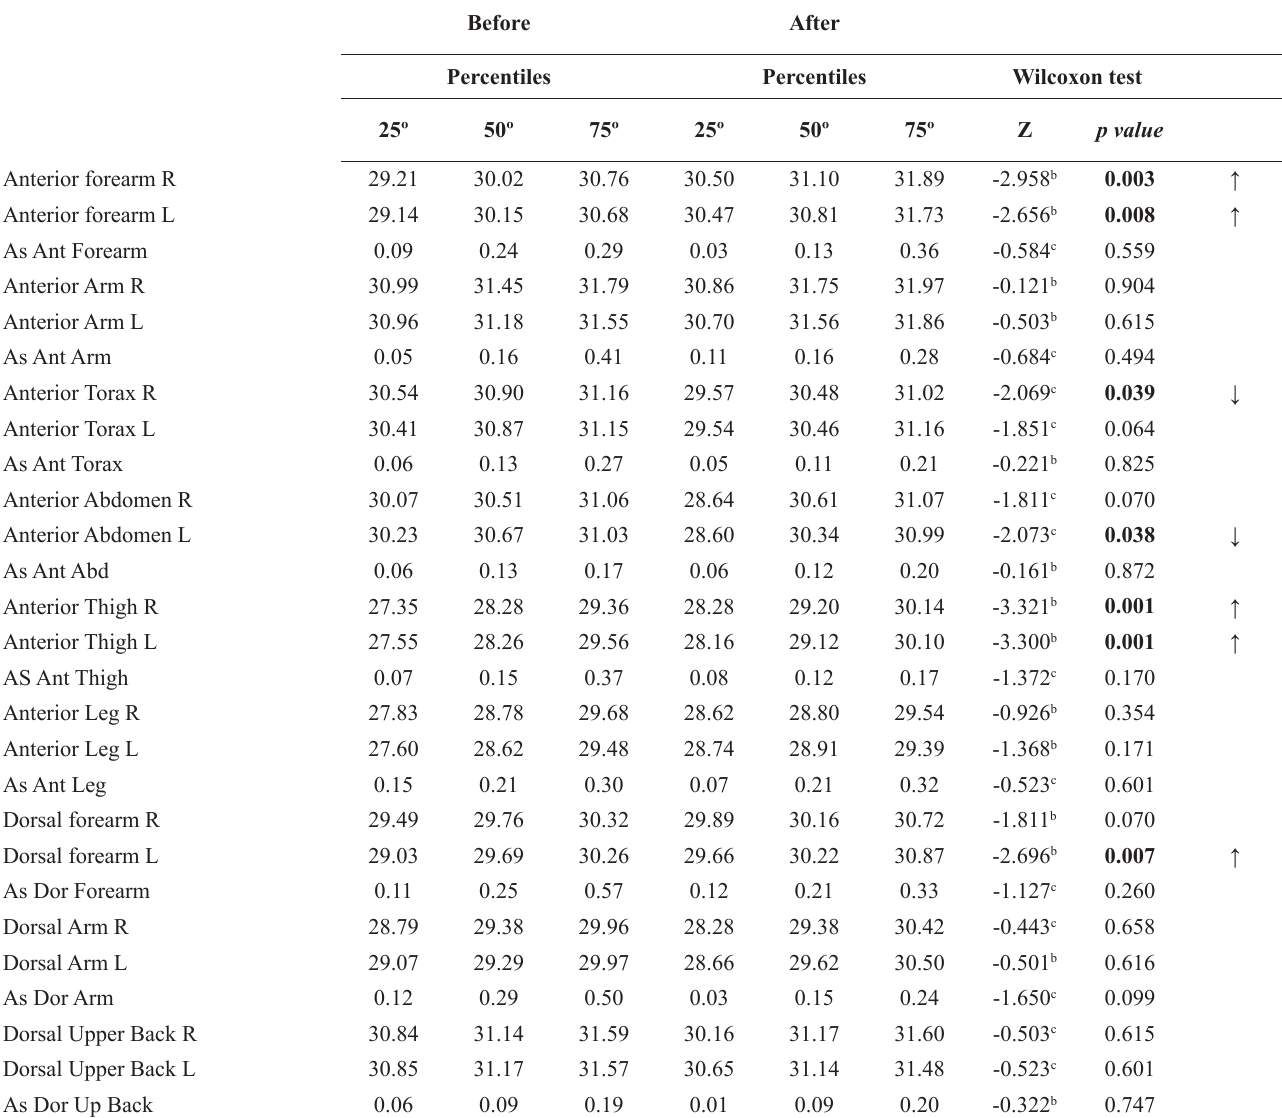
Table 2 - Skin temperature and thermal asymmetries measures of 19 volunteers (12 males and 7 females), before and after a session of CrossFit® training , Vila Real, Portugal, 2019